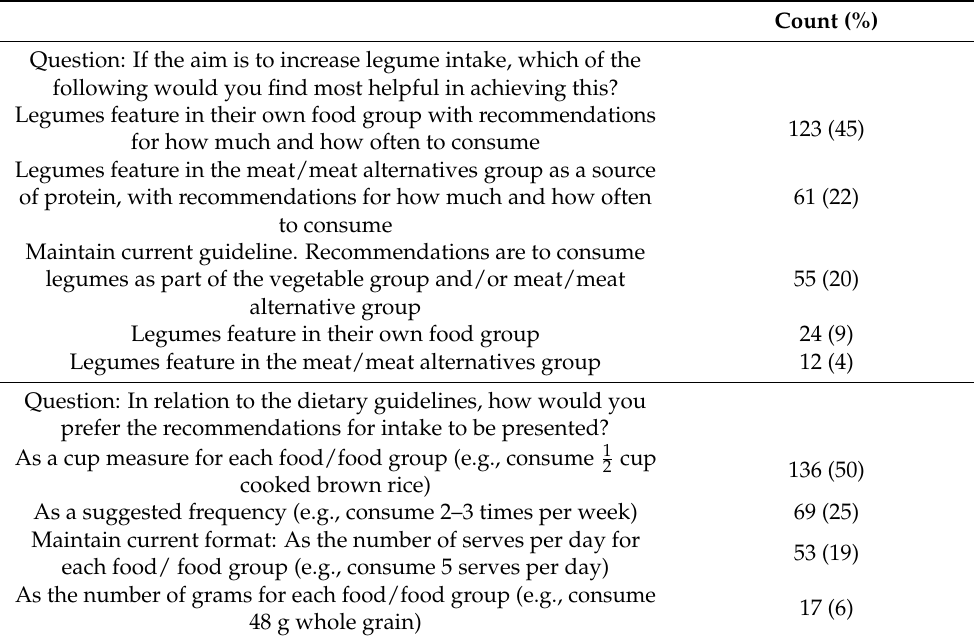
Table 4. Consumer preferences for guideline recommendations ( n = 275) *.